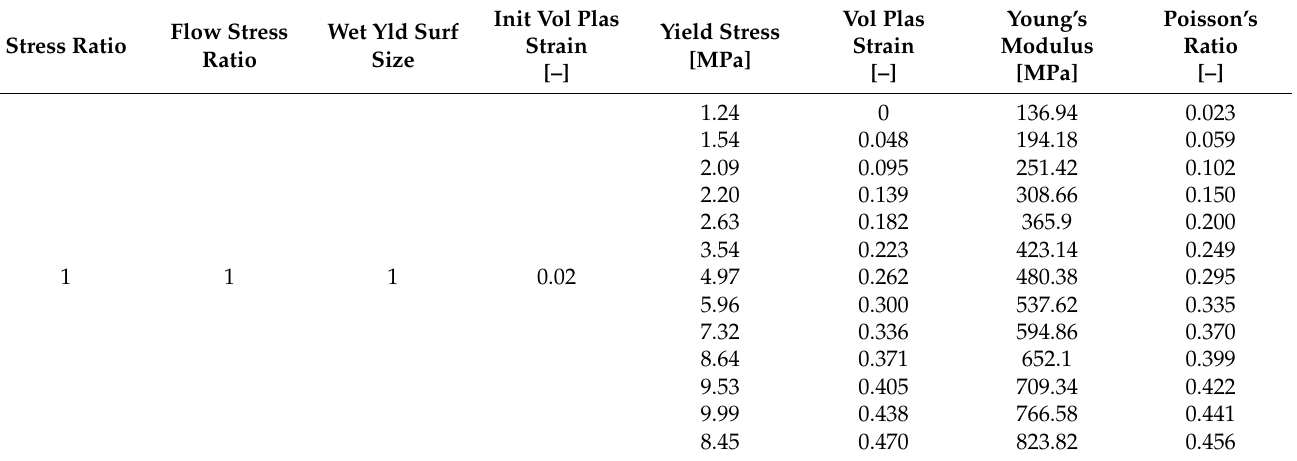
Table 2. Values of MCC model